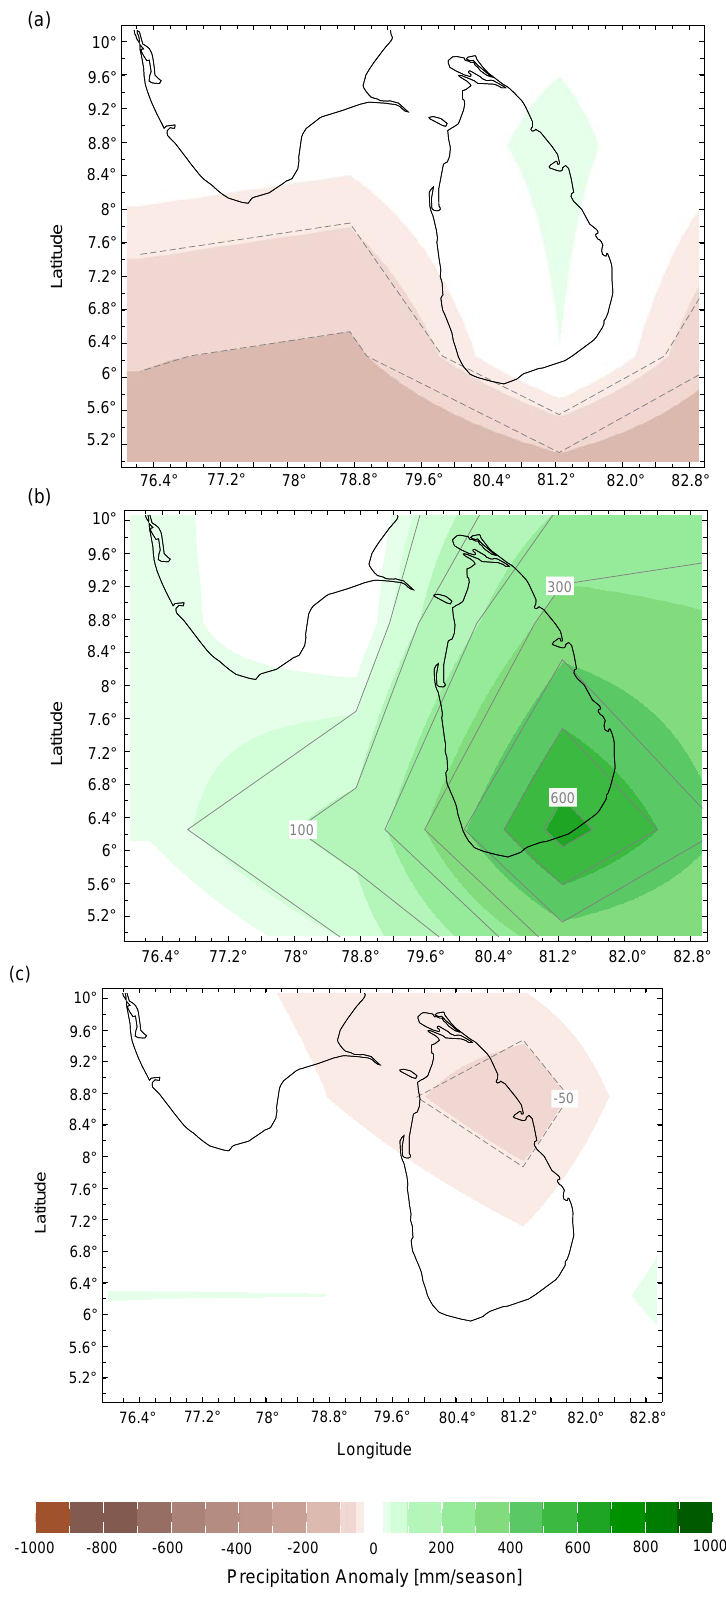
Figure 3. Seasonal precipitation anomaly around Sri Lanka for the period of ( a ) January–March 2009 ( b ) January–March 2011 and ( c ) January–March 2012. Green represents positive precipitation anomalies while brown represents negative precipitation